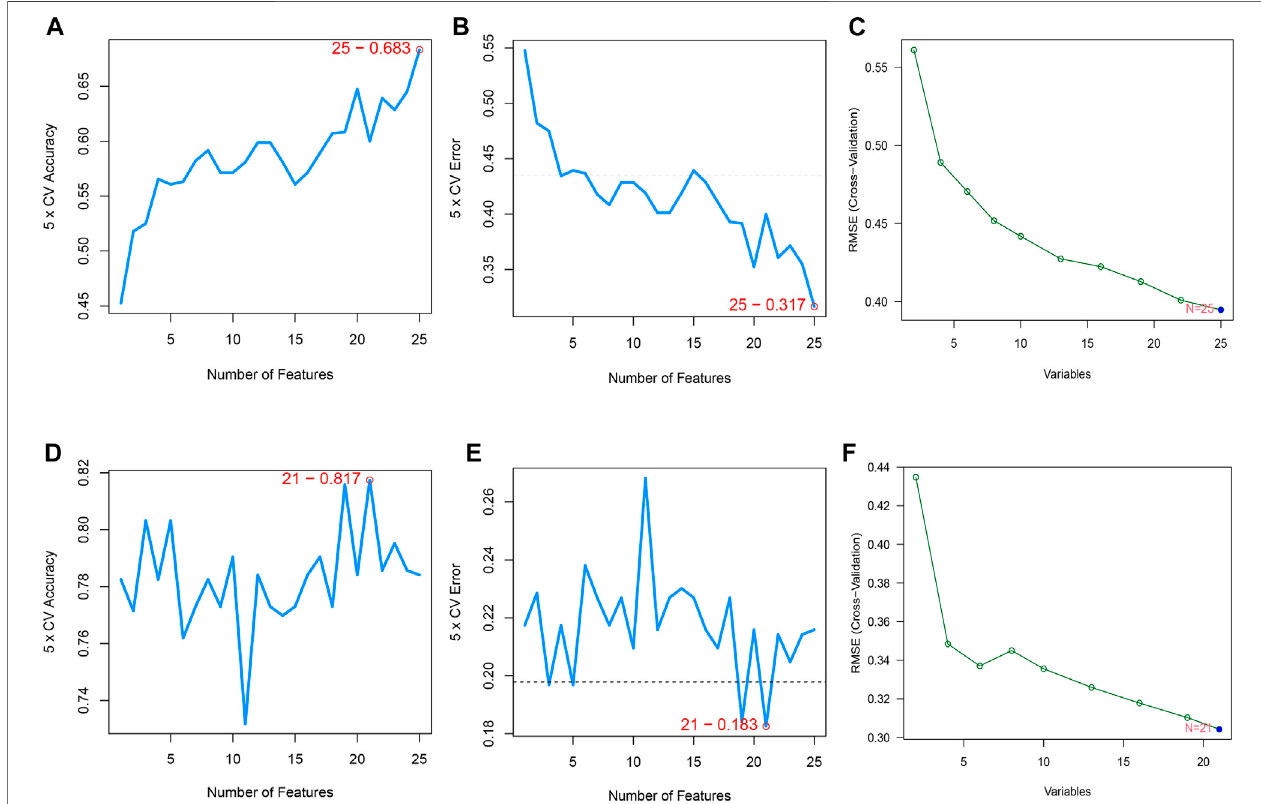
FIGURE3|(A,B) Featurerecursiveoptimizationshowingthatthehighestaccuracy,andthelowesterror,wasachievedwith25features(genes)intheOSAcohort. (C) The evaluation of RMSE in 15-fold cross-validation (CV) revalidated the results of SVM-RFE. (D,E) 21 features (genes) in the CPAP cohort were identi fi ed with the highest accuracy and lowest error obtained in the curves. The horizontal axis shows the number of feature selections based on CV, and the vertical axis shows the prediction accuracy (F) The RMSE was calculated from 15-fold CV and veri fi ed the results of